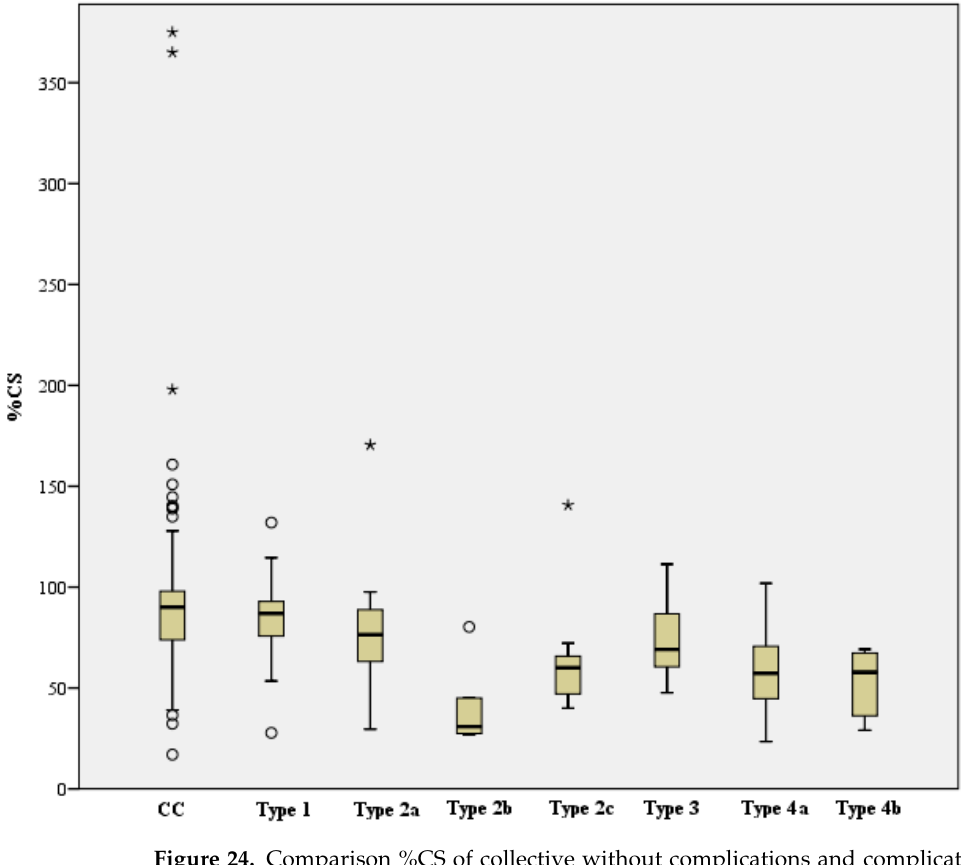
Figure 24. Comparison %CS of collective without complications and complication types (X-axis: study collective, Y-axis: median, IQR, o= extreme values, * = outliers). Table 4. Need for revision and distribution of revisions performed depending on the complication type. Depending on the complication type, the dominant procedures are highlighted by the dark- shaded